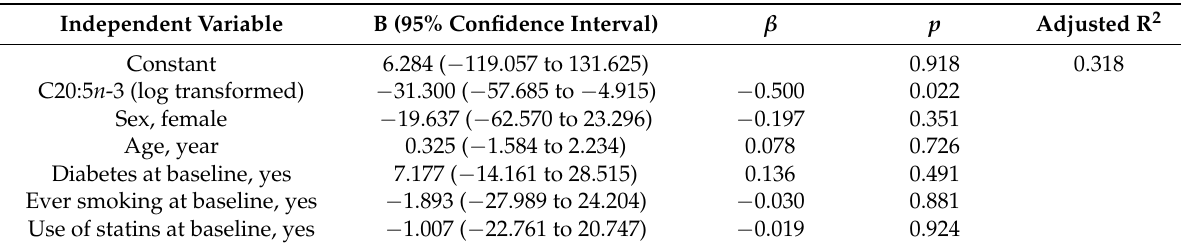
Table 4. Independent determinants of plaque lipid core burden by multiple regression